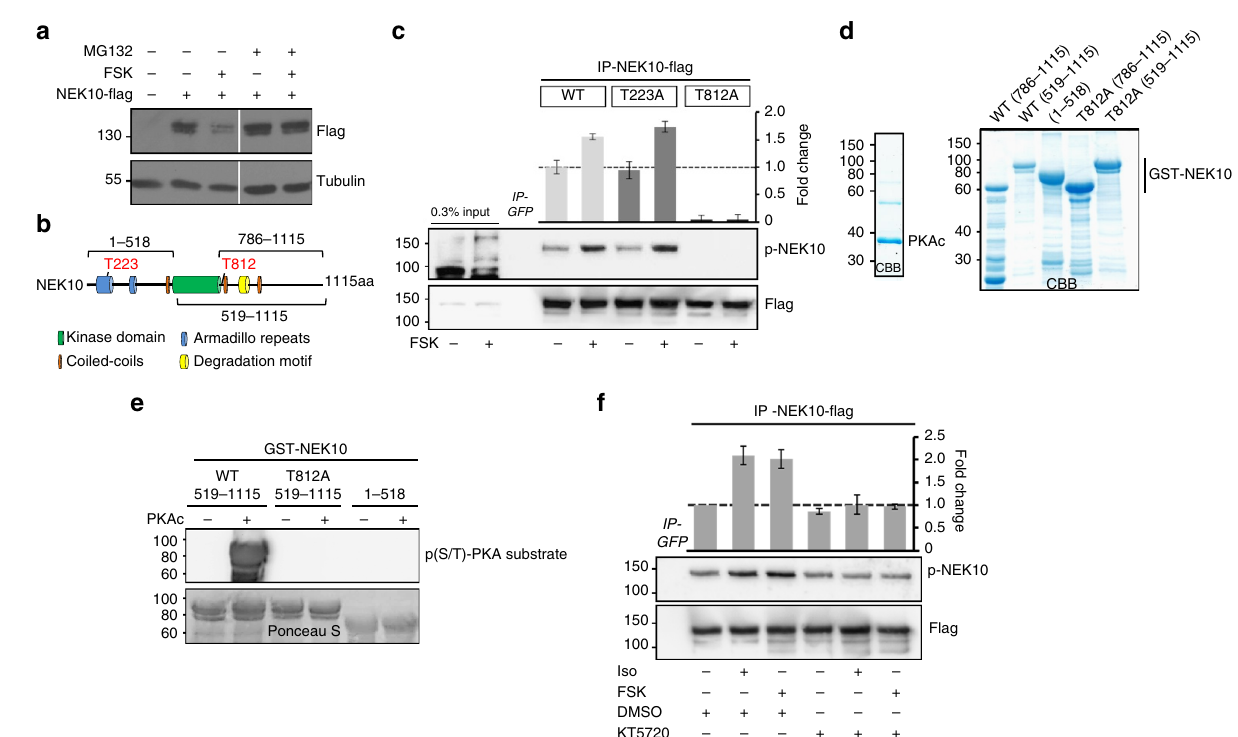
Fig. 3 PKA phosphorylates NEK10 in vivo and in vitro. a Transfected HEK293 cells were left untreated or stimulated with forskolin for 60 min. Where indicated, MG132 (20 µ M) was added to the medium. Lysates were immunoblotted for fl ag and tubulin. b The domain organization of NEK10 and the position of T223 and T812 are indicated. Composition of truncated NEK10 expression constructs are shown. c Cells transfected with either wild-type NEK10- fl ag or with NEK10- fl ag mutants (T223A-Flag and T812A-Flag) were left untreated or stimulated with FSK (15 min). NEK10 was immunopuri fi ed with anti- fl ag antibodies. The precipitates were immunoblotted with anti- fl ag and with anti-phospho-(K/R)(K/R)X(S*/T*) speci fi c antibodies. The quanti fi cation is shown from n = 4 independent experiments (±SEM). d Commassie brilliant blue (CBB) stained gels of recombinant GST hybrid NEK10 proteins composed of the phosphorylation site mutation T812A and distinct parts of NEK10 are shown. e Recombinant and GST-fused NEK10 proteins were used as substrates for in vitro phosphorylation assays using recombinant and hexa-histidin-tagged PKAc. GST-immobilized fusion proteins were analyzed in immunoblotting experiments with an anti-phospho-(K/R)(K/R)X(S*/T*) speci fi c antibody. Shown is a representative result from n = 3 independent experiments. f HEK293 cells transiently expressing NEK10- fl ag were treated with KT5720 (5 µ M; 60 min) and then stimulated with forskolin (20 µ M; 15 min) or isoproterenol (100 nM; 15 min). Cells were lysed and NEK10- fl ag was immunoprecipitated using anti- fl ag antibodies. Immunoblotting was performed with anti- fl ag and with anti-phospho-(K/R)(K/R)X(S*/T*) speci fi c antibodies. The quanti fi cation from n = 4 independent experiments (±SEM) is